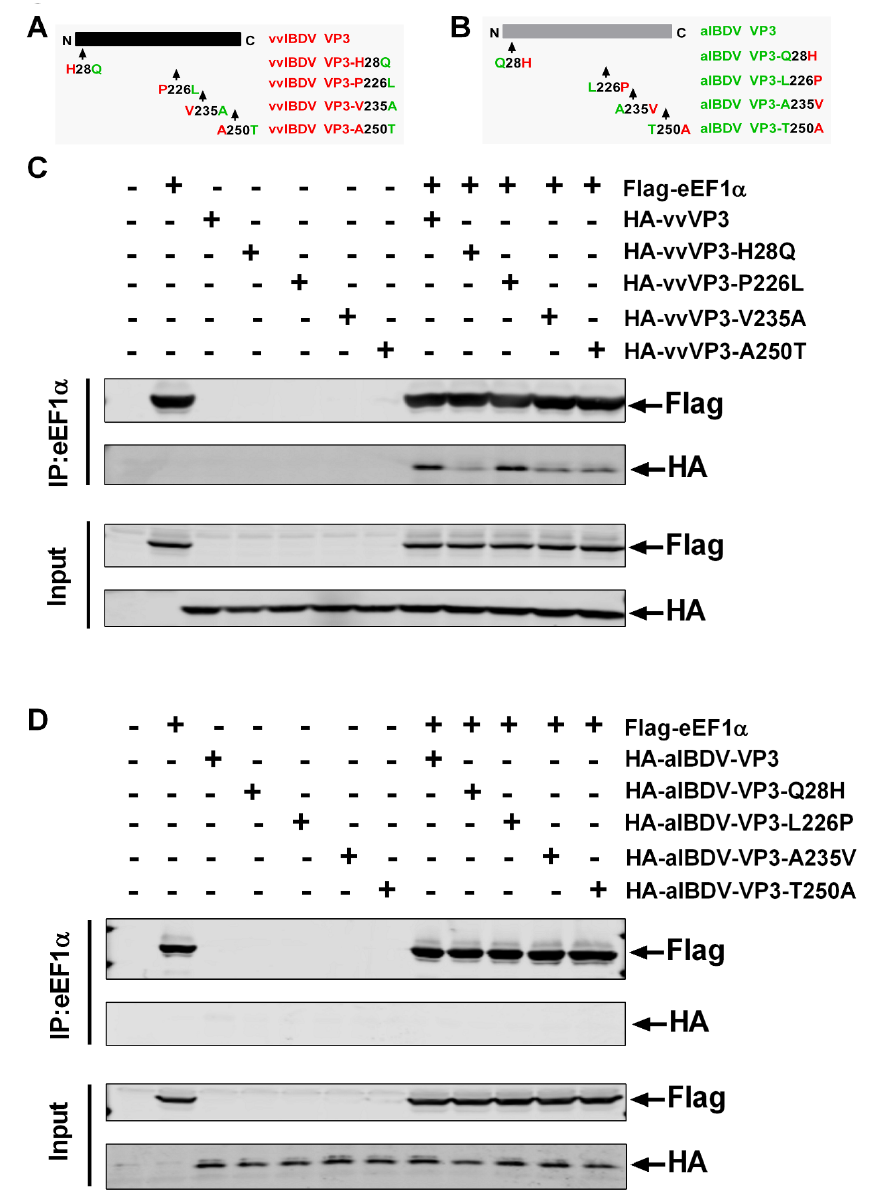
Figure 4. Both N- and C-terminal amino acids of VP3 are essential in the interaction between vvIBDV VP3 and cheEF1 α . ( A ) Four mutant plasmids with only one amino acid mutation including vvIBDV- VP3-H28Q, -VP3-P226L, -VP3-V235A, and -VP3-A250T were constructed using vvIBDV VP3 as the template. ( B ) Four mutant plasmids aIBDV-VP3-Q28H, -VP3-L226P, -VP3-A235V, and -VP3-T250A with one amino acid substitution were constructed with attenuated VP3 as the template. ( C ) 293T cells were transfected expression plasmids with Flag-cheEF1 α and HA-vvIBDV VP3, Flag-cheEF1 α and vvIBDV-VP3-H28Q, Flag-cheEF1 α and vvIBDV-VP3-P226L, Flag-cheEF1 α and vvIBDV-VP3-V235A, or Flag-cheEF1 α and vvIBDV-VP3-A250T. Cell lysates were prepared at 36 h post-transfection and immunoprecipitated with anti-Flag antibody and immunoblotted with anti-Flag or anti-HA antibodies. ( D ) 293T cells were transfected expression plasmids with Flag-cheEF1 α and HA-aIBDV VP3, Flag-cheEF1 α and aIBDV-VP3-Q28H, Flag-cheEF1 α and aIBDV-VP3-L226P, Flag-cheEF1 α and aIBDV-VP3-A235V, or Flag-cheEF1 α and aIBDV-VP3-T250A. Cell lysates were prepared at 36